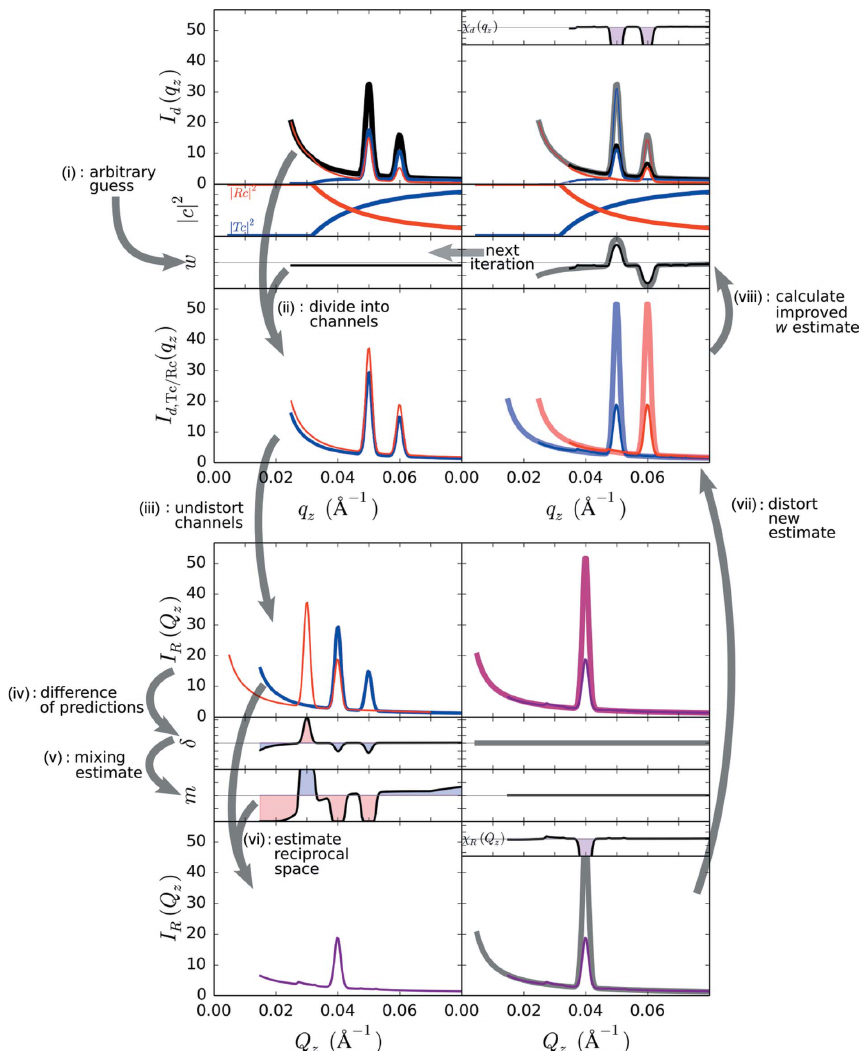
Figure 7 Algorithm for generating an initial estimate of the undistorted scattering ½ I ð q Þ(cid:5) . The experimental intensity is first divided into contributions from the GISAXS data ½ I z d transmitted and reflected channels ( Tc and Rc ) based on known transmission/reflectivity curves ( j Tc j 2 and j Rc j 2 ) and an arbitrary guess for the ratio between the channels ( w ). The two channels are both undistorted into reciprocal space, which provides two predictions for the true scattering (which should agree). The difference between these predictions is used to compute an improved estimate for I . This I estimate can be distorted to yield new estimates for the contributions from the two R R channels, which provides an improved estimate for w . This new w estimate can be fed back as an improved initial guess. (Thick faded lines show true scattering contributions, while (cid:6) shows the corresponding residuals; these are of course not known during reconstruction of experimental data.) By iterating through this procedure, the algorithm converges towards a self-consistent prediction for Þ and I ð Q Þ w ð q z R z